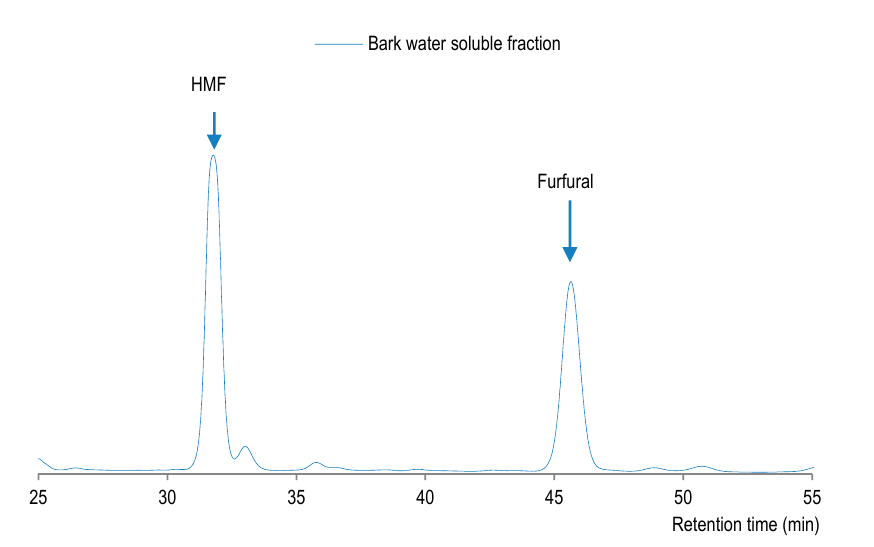
Figure 4. HPLC profile of water-soluble fraction from organosolv pulping of pre-extracted sugar maple bark.